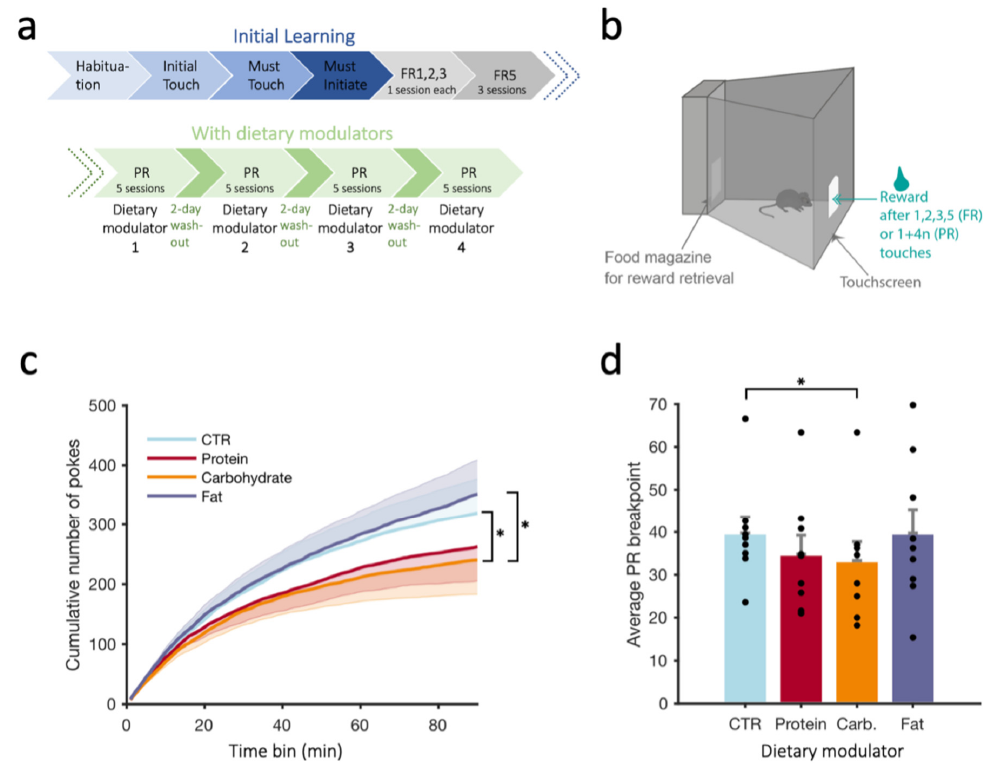
Figure 2. ( a ) Timeline of the habituation, fixed ratio (FR), and progressive ratio (PR) schedules during the learning phase (without dietary modulators) and under dietary modulators. ( b ) Schematic of the apparatus of the FR and PR tasks. ( c ) Cumulative number of pokes across a 90 min session for each dietary modulator. Each line represents the average over 5 sessions for each modulator. ( d ) PR breakpoint across the dietary modulators (average over 5 sessions for each modulator). Black dots indicate individual animals; animals with the same values overlap. Values reported as mean + SEM (mean-SEM for protein and carbohydrate in ( c )). N = 9 mice. p -values reported as follows: * p ≤ 0.05.